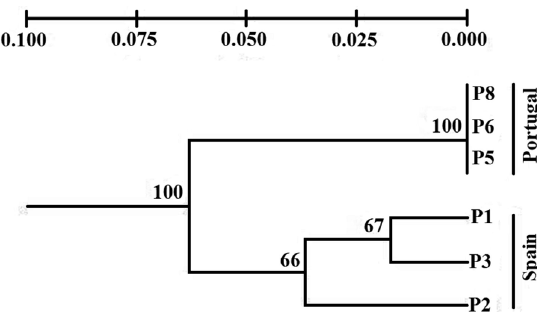
Fig. 2. UPGMA cluster analysis using Nei’s genetic distance calculated for six populations of E. andevalensis . Portuguese and Spanish populations are indicated.